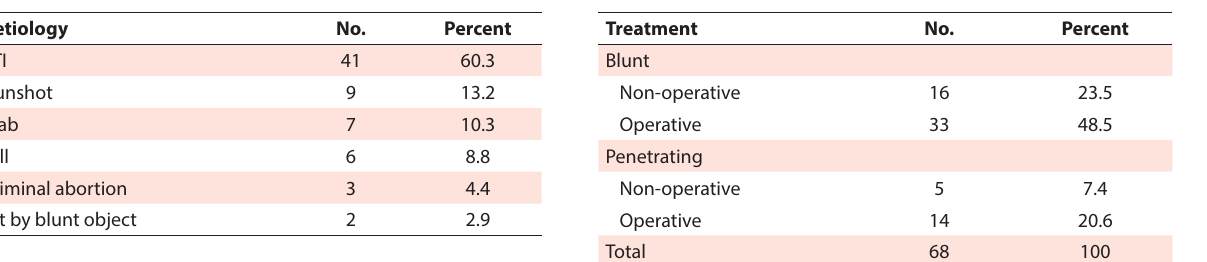
Table 1. Mechanisms of injuries